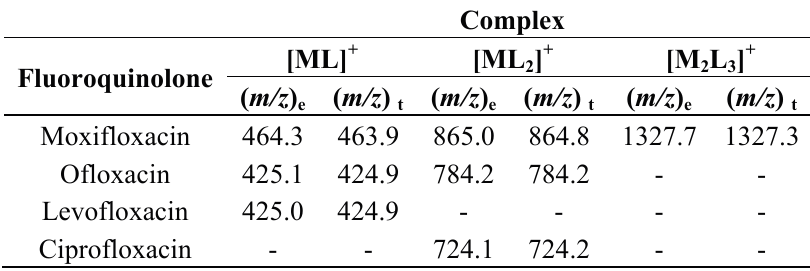
6. Experimental and theoretical m/z values of ESI-MS